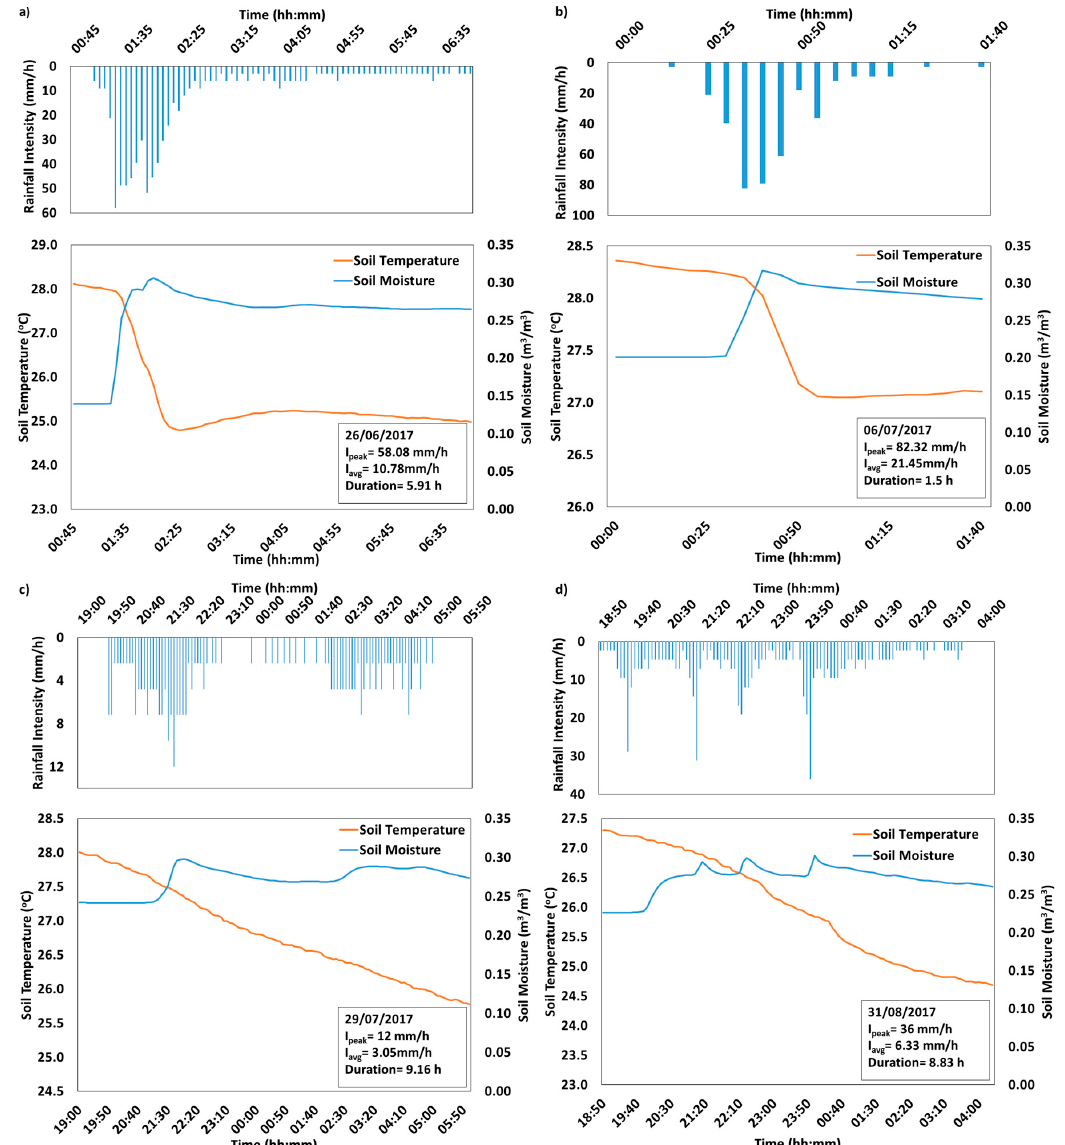
Figure 4. Influence of rainfall on soil moisture and soil temperature dynamics in GA hillslope during four different rainfall events ( a – d ). The details about the rainfall events are mentioned in lower right corner of the plots.